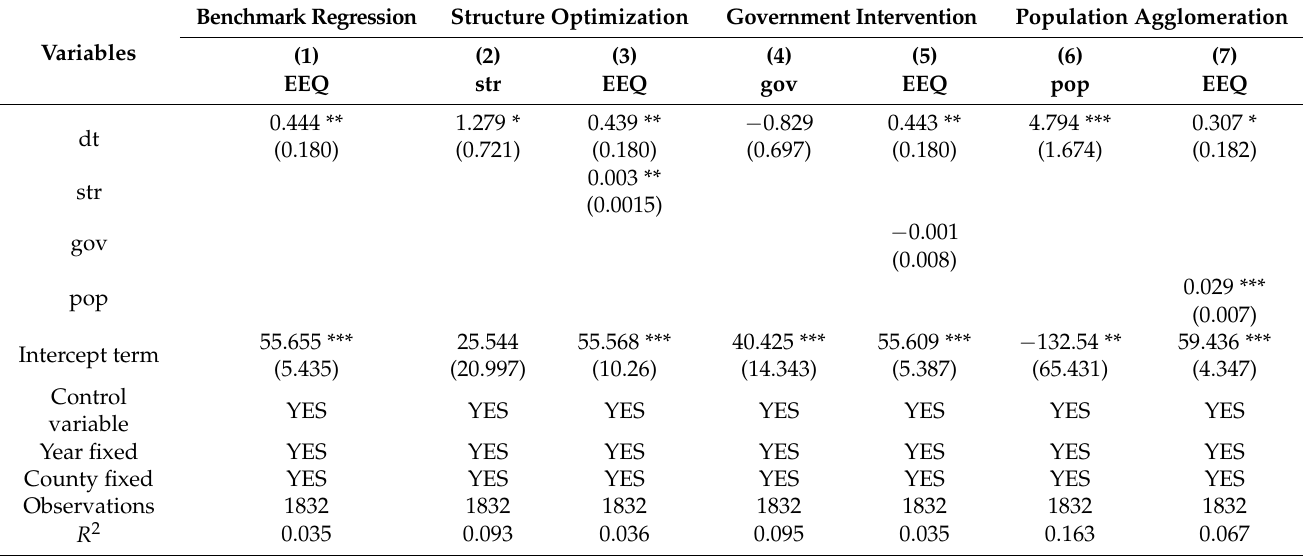
Table 6. Driving mechanism test of MERCOCL on EEQ.